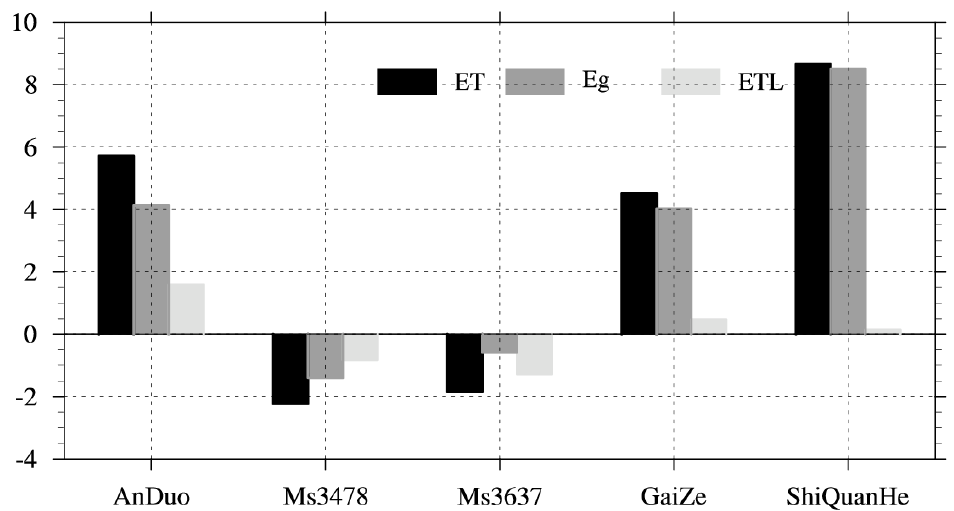
Figure 6. The variations in evapotranspiration from the canopy to atmosphere (ET), evaporation from the ground (Eg) and ETL (units: mm/day) due to the parameter errors characterized by the CNOP-Ps at different Tibetan sites when LH was chosen as the objective state variable in the CNOP-P approach. For each site, the variations denote the changes averaged over the entire study period, which was introduced in Table 1.